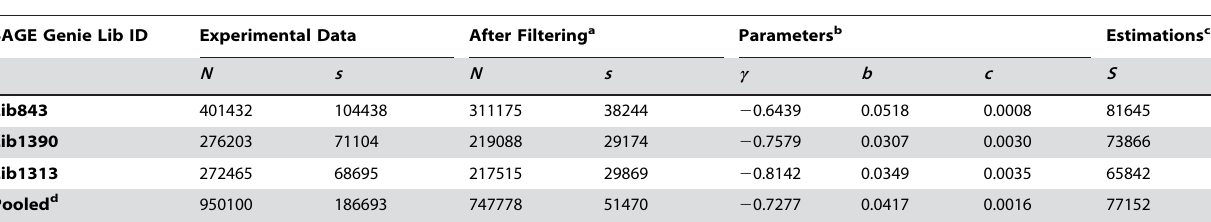
Table 1. Parameters and estimations under GIGP model.